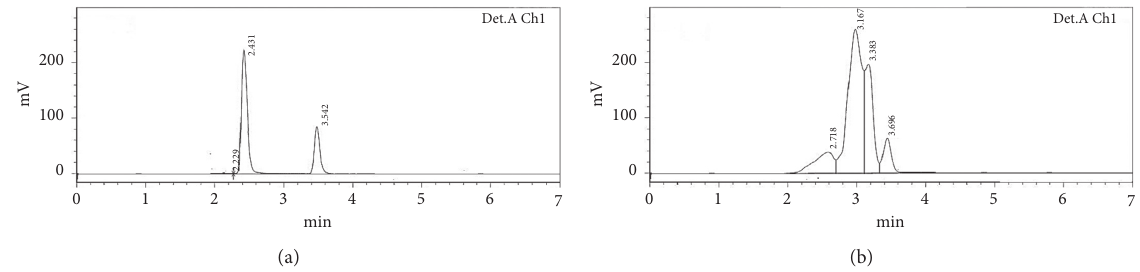
Figure 5: HPLC chromatogram of atorvastatin: (a) oxidative degradation and (b) UV light